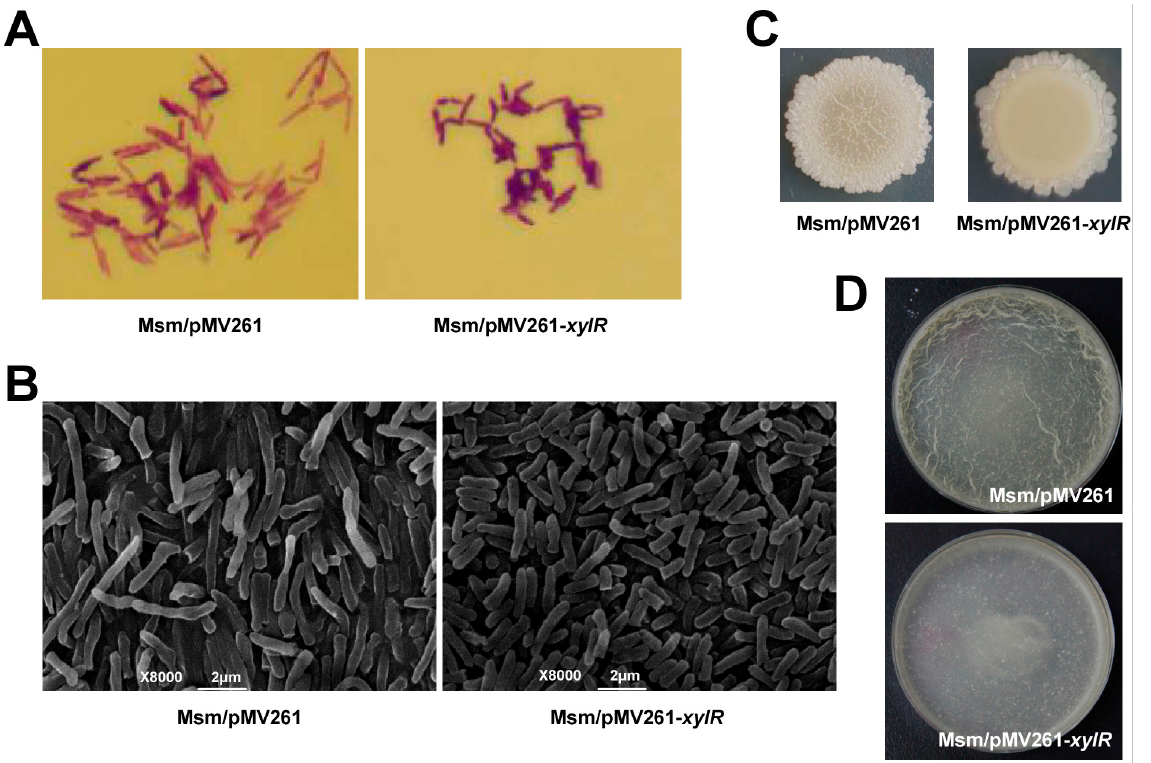
Figure 5. Effects of XylR on bacterial size, colony morphology, and biofilm formation of M. smegmatis . ( A ) The observation of M. smegmatis with a light microscope after staining with 2% crystal violet. ( B ) Scanning electron microscopy assays of cell morphology. The images were taken at 8000× magnification. ( C ) Representative colony morphology of Msm/pMV261 (left panel) and Msm/pMV261- xylR (right panel). All recombinant mycobacterial strains were spot and grown on 7H10 medium. ( D ) The difference in surface morphology of the biofilm at air-liquid interface between the Msm/pMV261 (the upper panel) and Msm/pMV261- xylR (the lower panel) strains. All recombinant mycobacterial strains were grown in M63